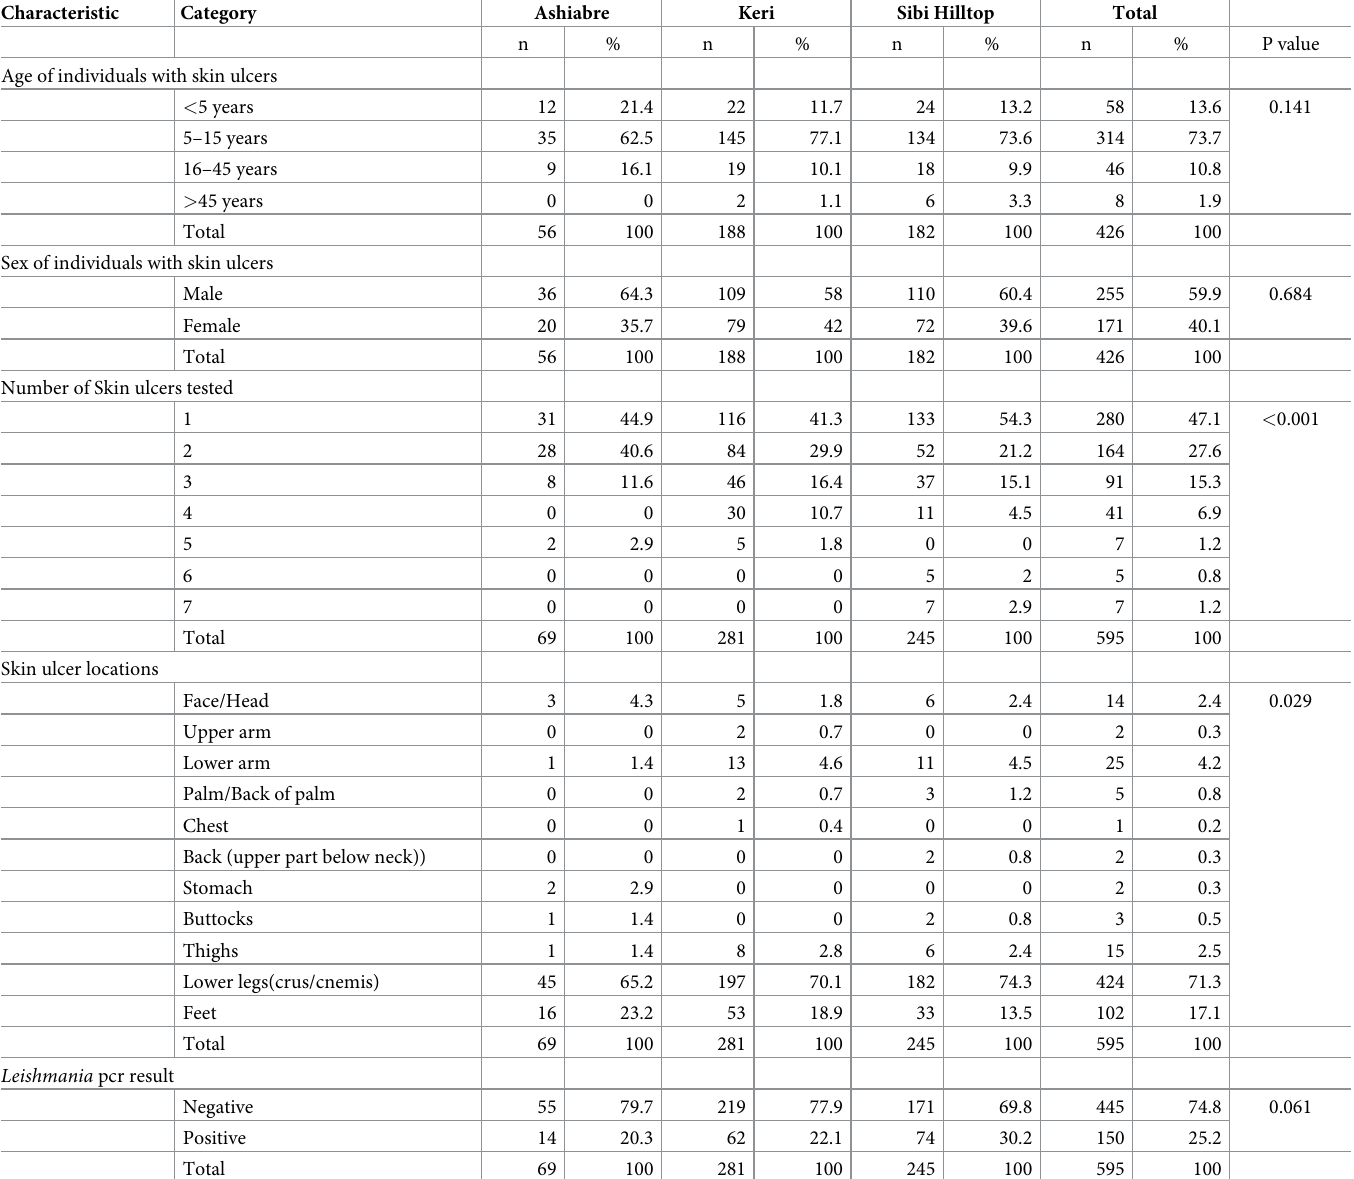
Table 1. Individuals with skin ulcers, ulcers sampled and result of Leishmania PCR test. Characteristic Category